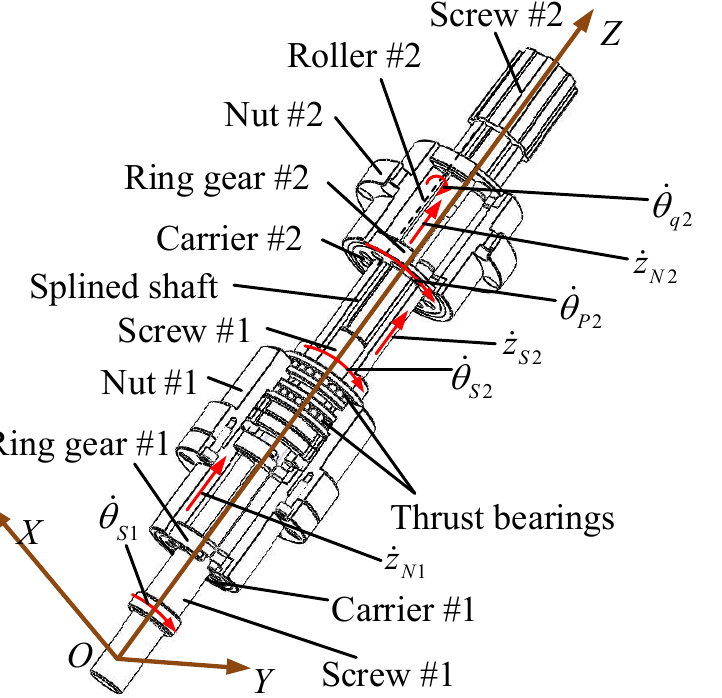
Figure 13. Structure and motion analysis of a two-stage planetary roller screw mechanism in Ref. [69].